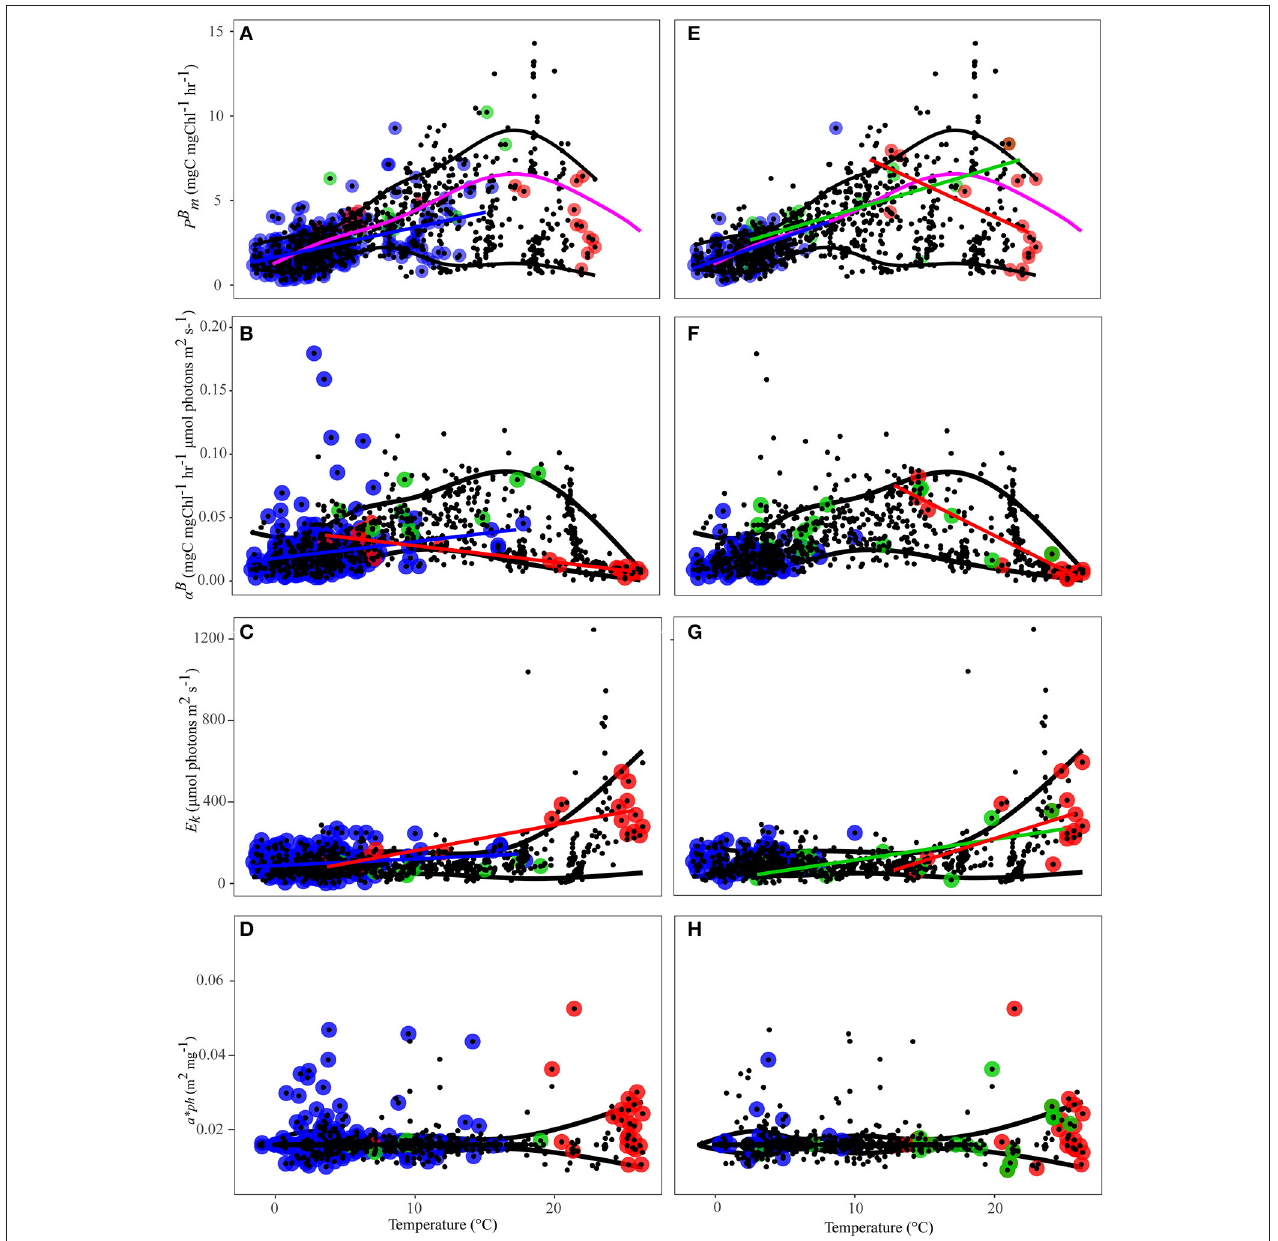
FIGURE 6 | PE parameters as a function of temperature: (A) is Uitz P B m ; (B) is Uitz α B ; (C) is Uitz E k ; (D) is Uitz a ph * ; (E) is Sathyendranath P B m ; (F) is Sathyendranath α B ; (G) is Sathyendranath E k ; (H) is Sathyendranath a ph * . Micro-phytoplankton ( > 20 µ m) is blue circles, nano-phytoplankton (2–20 µ m) is green circles, and pico-phytoplankton ( < 2 µ m) is red circles. Black points represent samples classified as “mixed” populations; blue regression line is for micro-, green regression line is for nano- and red regression line is for pico-phytoplankton, black lines are the 10 and 90% quantiles fitted using a running average over all samples, the pink line is the 7th order polynomial relationship from Behrenfeld and Falkowski